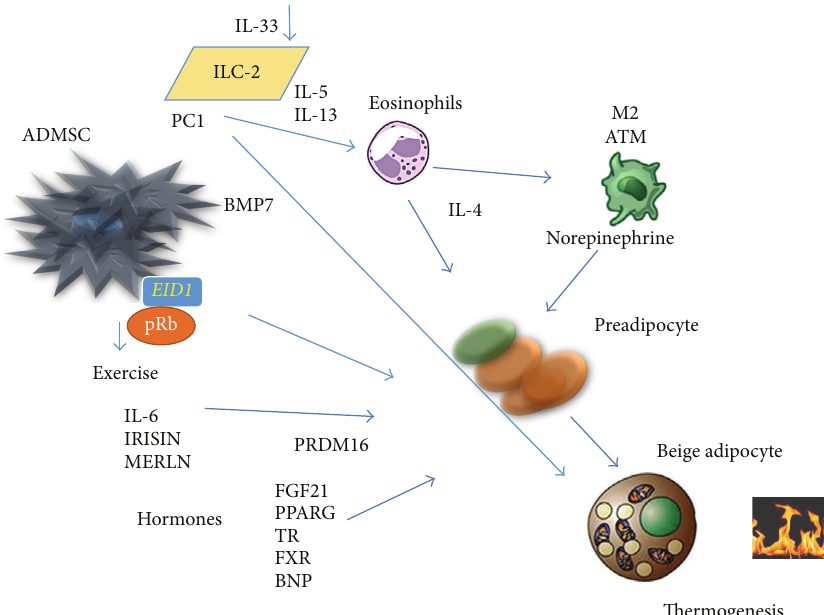
Figure 2: Determining factors in differentiation of beige adipose cell. The adipose mesenchymal cells can be influenced by the retinoblastoma protein (pRb) and take decision to differentiate into fat cells when pRb is blocked. The EID1 protein among others can determine the differentiation of beige cells adipocytes from mesenchymal stem cells (see [11]). BMP7 triggers production of mesenchymal adipose cells to brown adipose cells. Both exercise and some hormones can increase the capacity of adipose stem cells to differentiate into beige adipocytes. Recently, it has been observed that cells of the innate immune system type 2 can secrete interleukins stimulating the production of IL- 4 by eosinophils and norepinephrine production through macrophage type 2. IL-33 has the ability to activate the differentiation of beige adipocytes directly. ADMSC: adipose mesenchymal stem cell; PC1: Prohormone Convertase 1; ILC-2: group 2 innate lymphoid cells; BMP7: bonemorphogenicprotein7;EID1:EP300-interactinginhibitorofdifferentiation1;M2ATM:adiposetissuemacrophage2;FGF21:fibroblastic growth factor 21; PPARg: peroxisome proliferator-activated receptor gamma; TR: thyroid receptors; FXR: farnesoid X receptor; BNP: brain natriuretic